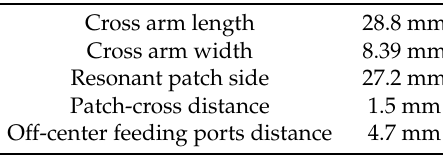
Table 1. Geometry